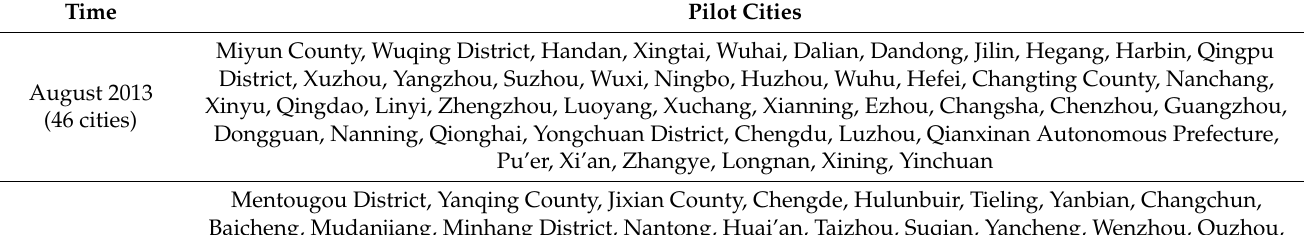
Table 1. Lists of water ecological civilization pilot cities.